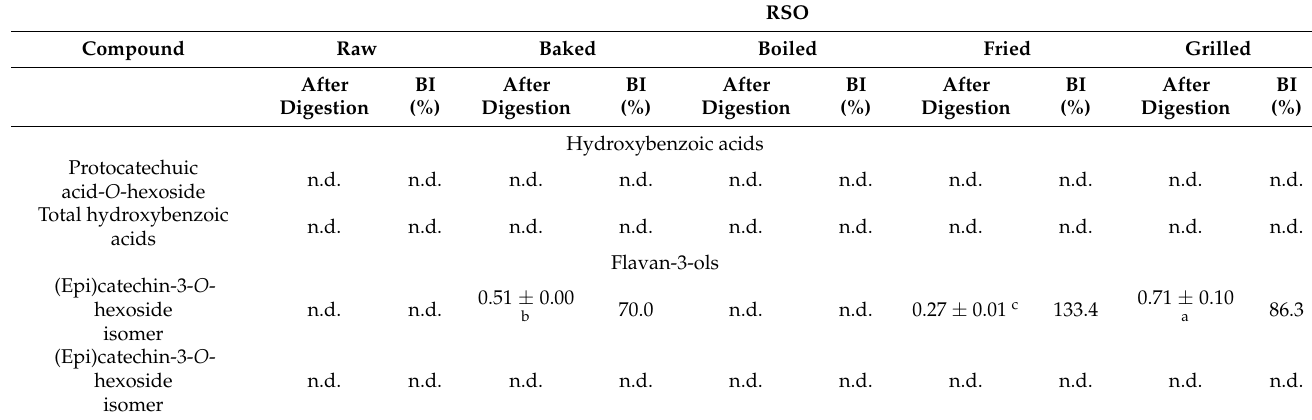
Table 5. Amount of phenolic compounds in raw and cooked red-skinned onion (RSO) after in vitro gastro-intestinal digestion. Results are expressed in mg of phenolic compound/100 of raw or cooked onion. Bioaccessibility index (BI) is the percentage ratio between the concentration after in vitro gastro-intestinal digestion and the concentration before digestion. RSO Compound Raw Baked Boiled Fried Grilled After BI After BI After BI After BI After BI Digestion (%) Digestion (%) Digestion (%) Digestion (%) Digestion